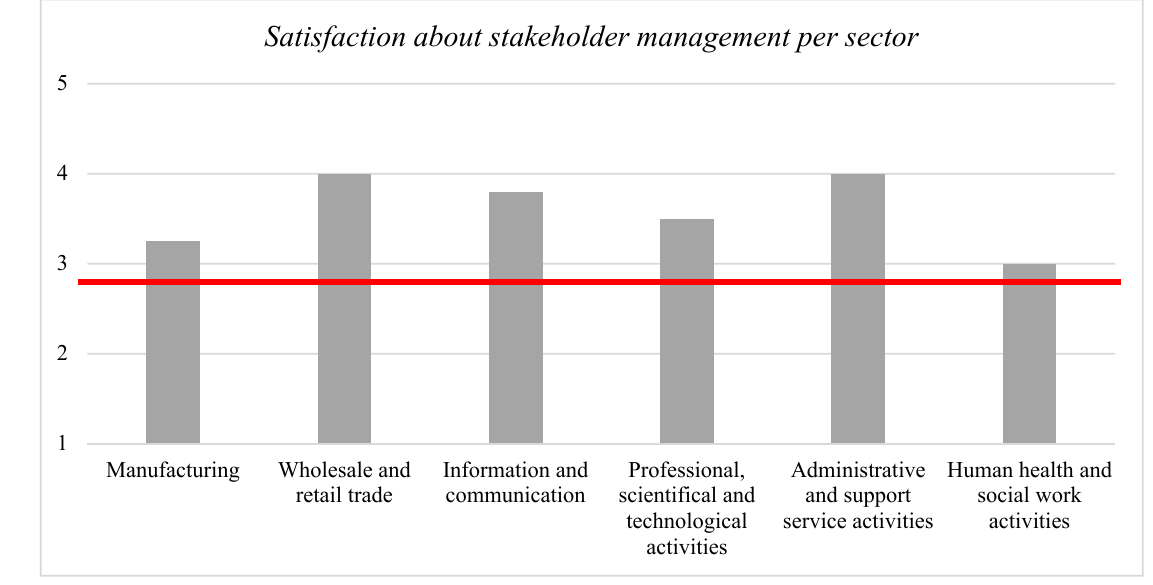
Figure 10. Stakeholder management satisfaction scores from the USO’s respondents per sector.